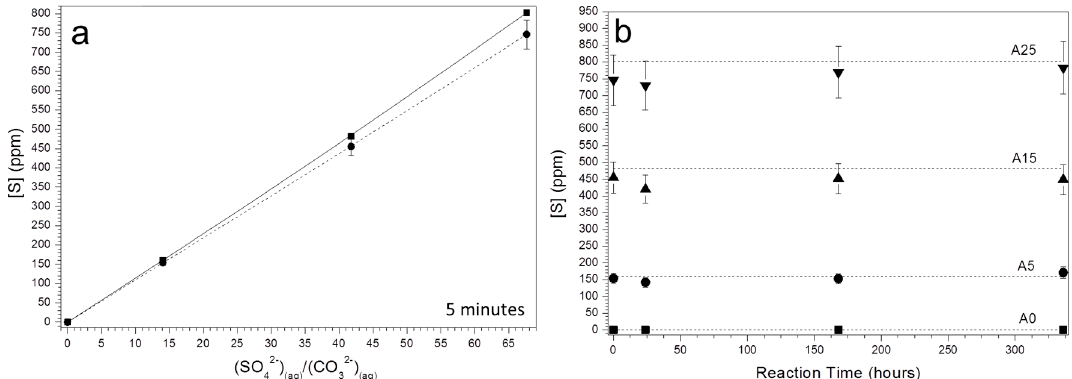
Figure 7. ( a ) The concentration of S (from inductively coupled plasma-optical emission spectrometry (ICP-OES) analyses) in aqueous solutions sampled after 5 min of reaction as a function of the initial (SO 42 − )/(CO 32 − ) ratios (dashed lines): The initial concentrations of S in the solutions are connected by a solid line. ( b ) The evolution of the concentration of S (from ICP-OES) of aqueous solutions with initial (SO 42 − )/(CO 32 − ) ratios of 0 (A0), 14.3 (A5), 41.8 (A15), and 67.7 (A25), respectively.